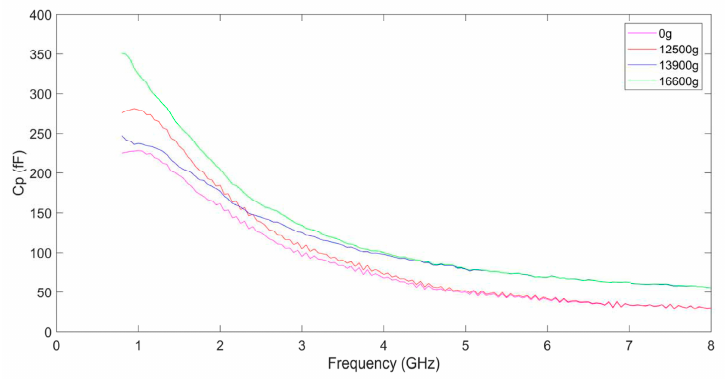
Figure 15. The parasitic capacitance of the MEMS suspended inductors.